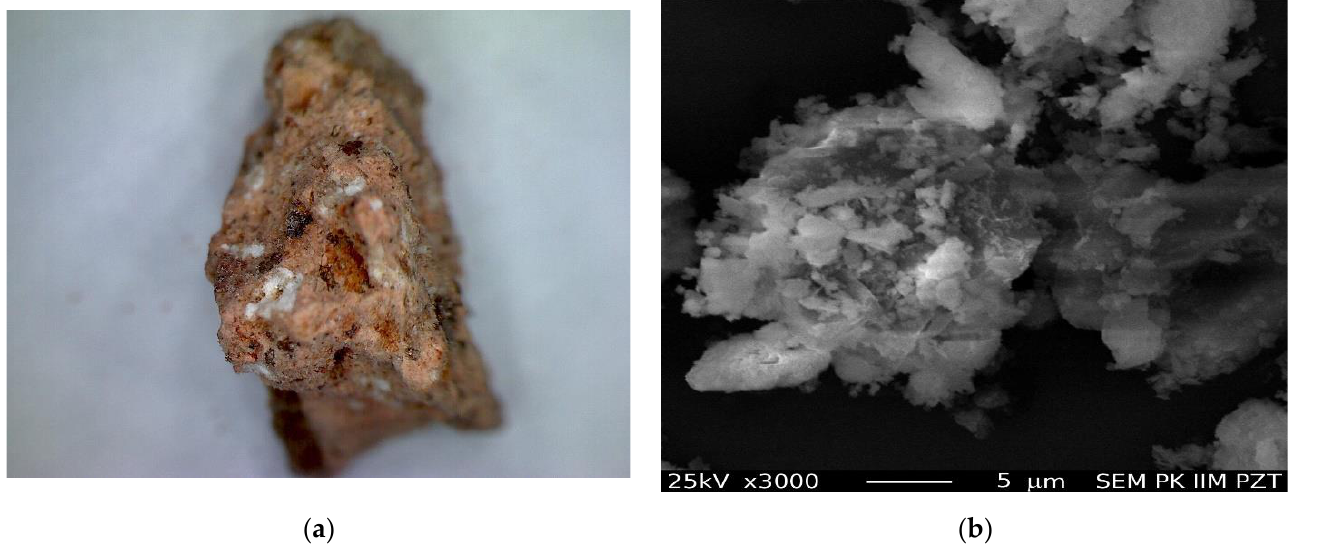
Figure 2. Morphology of the particles of tuff used for research: ( a ) Tuff in the form of a fragment of a rock; ( b ) at a magnification of 3000X [33].